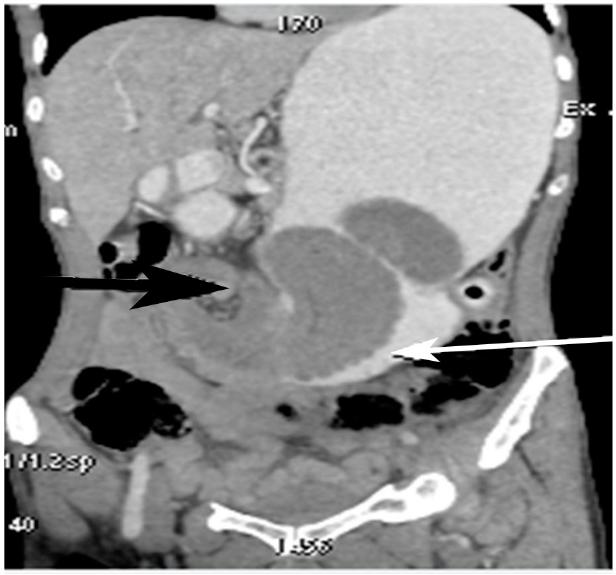
Fig. 2. Coronal CECT of the patient showing retrograde intussusception of the jejunal efferent loops (white arrow) within the stomach, and a central hypodense (black arrow) area is seen giving a fat density, suggestive of mesenteric fat with mesenteric vessels that had intussuscepted along with the